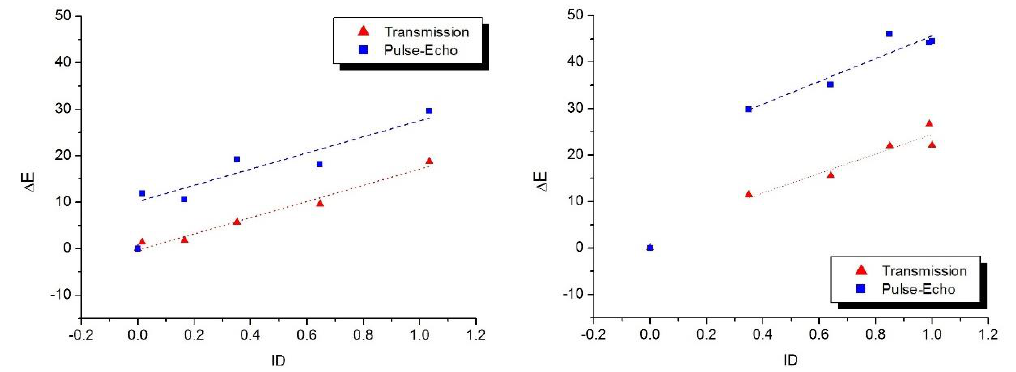
Figure 16. ∆ E values corresponding to Transmission and Pulse-Echo methods. ( Left ) specimens DC1–DC5, ( Right ) specimens